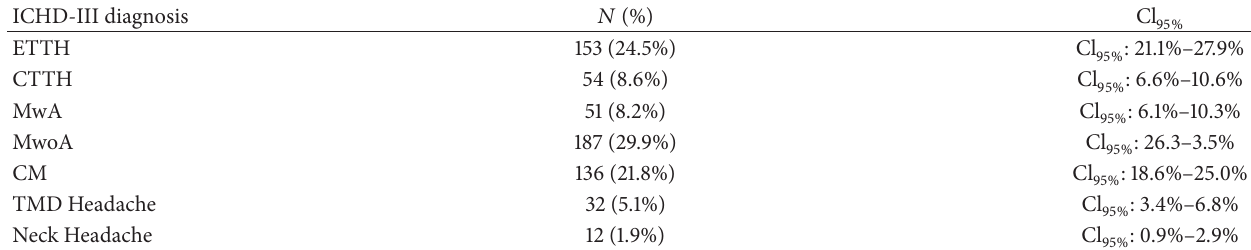
Table 1: Absolute frequency ( 𝑁 ) and percentage (%) values of headache types in Group with Headache (GwH), according to the ICHD-III. ETTH: Episodic Tension Type Headache; CTTH: Chronic Tension Type Headache; MwA: Migraine with Aura; MwoA: Migraine without